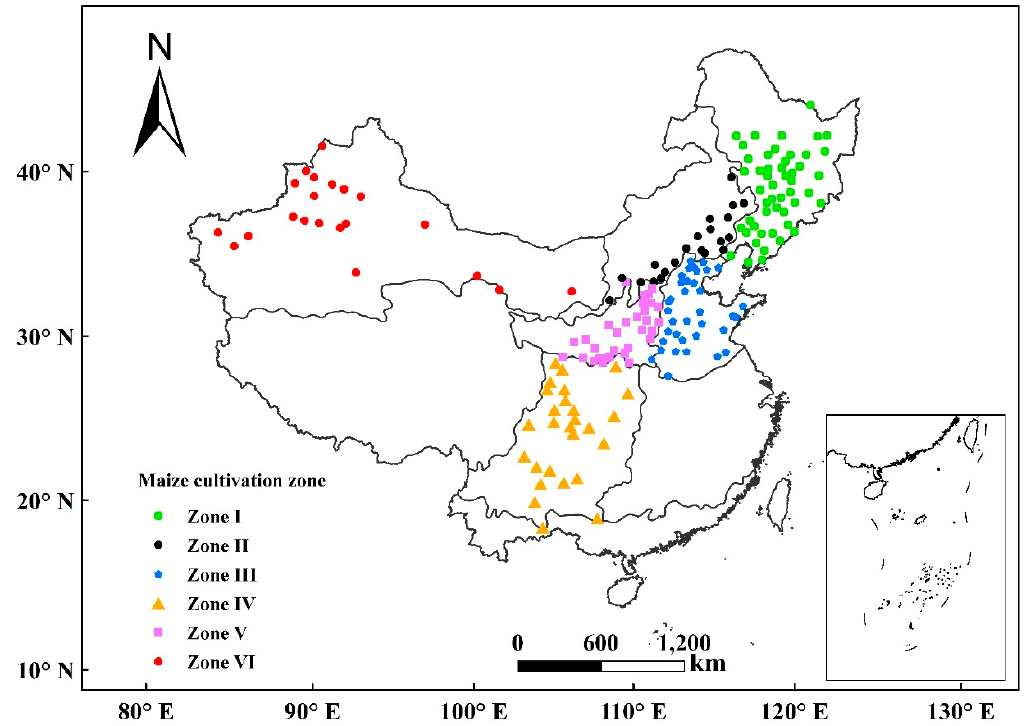
Figure 1. Maize cultivation zones of China, and the locations of agricultural meteorological stations in the cultivation zones.